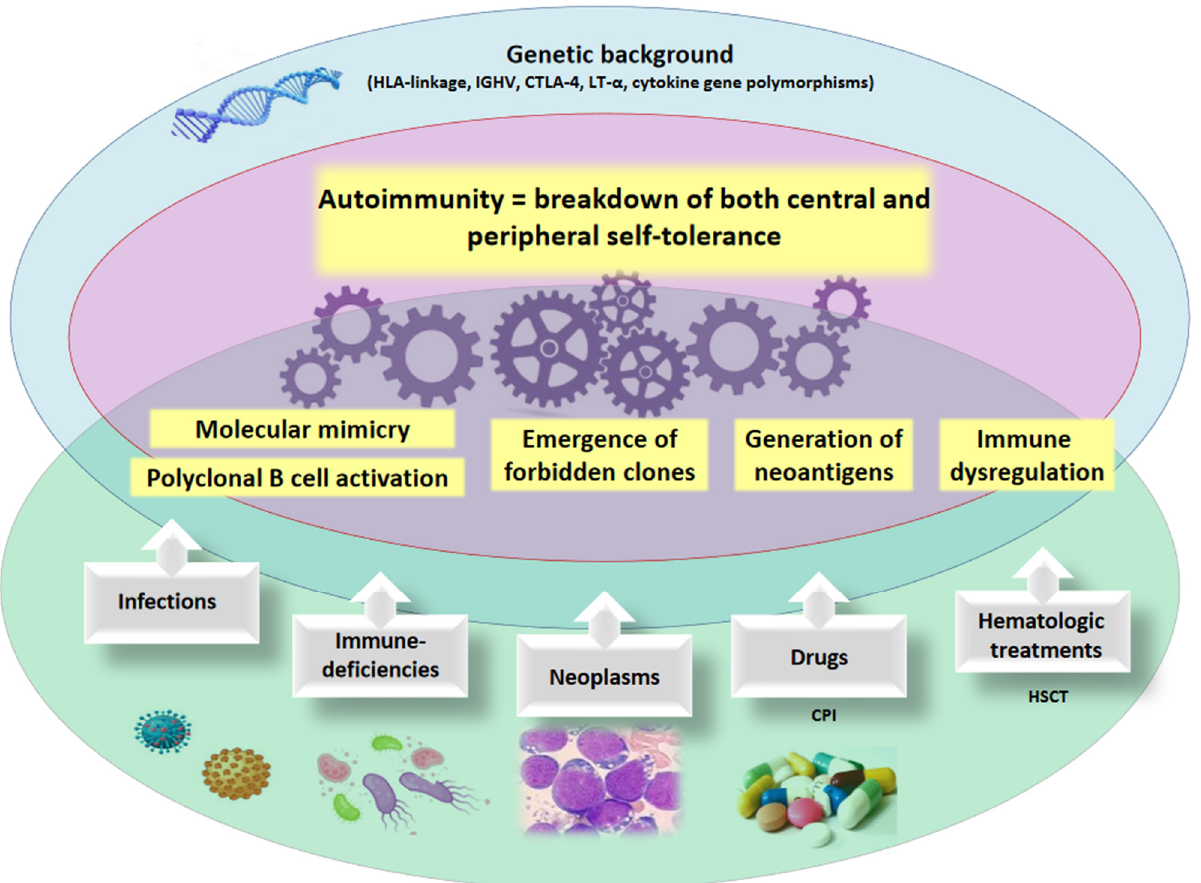
Figure 1. Mechanisms of autoimmunity. The pathogenic mechanisms of autoimmunity involve a genetic susceptibility (i.e., HLA genotype, cytokine polymorphisms, etc.) and the occurrence of acquired, environmental factors (i.e., infectious agents, neoplastic clones, medical/cellular therapies). HLA human leukocyte antigens, IGHV immunoglobulin heavy variable, CTLA-4 cytotoxic T-lymphocyte antigen-4, LT- α lymphotoxin- α , CPI checkpoint inhibitors, HSCT hematopoietic stem cell transplant.